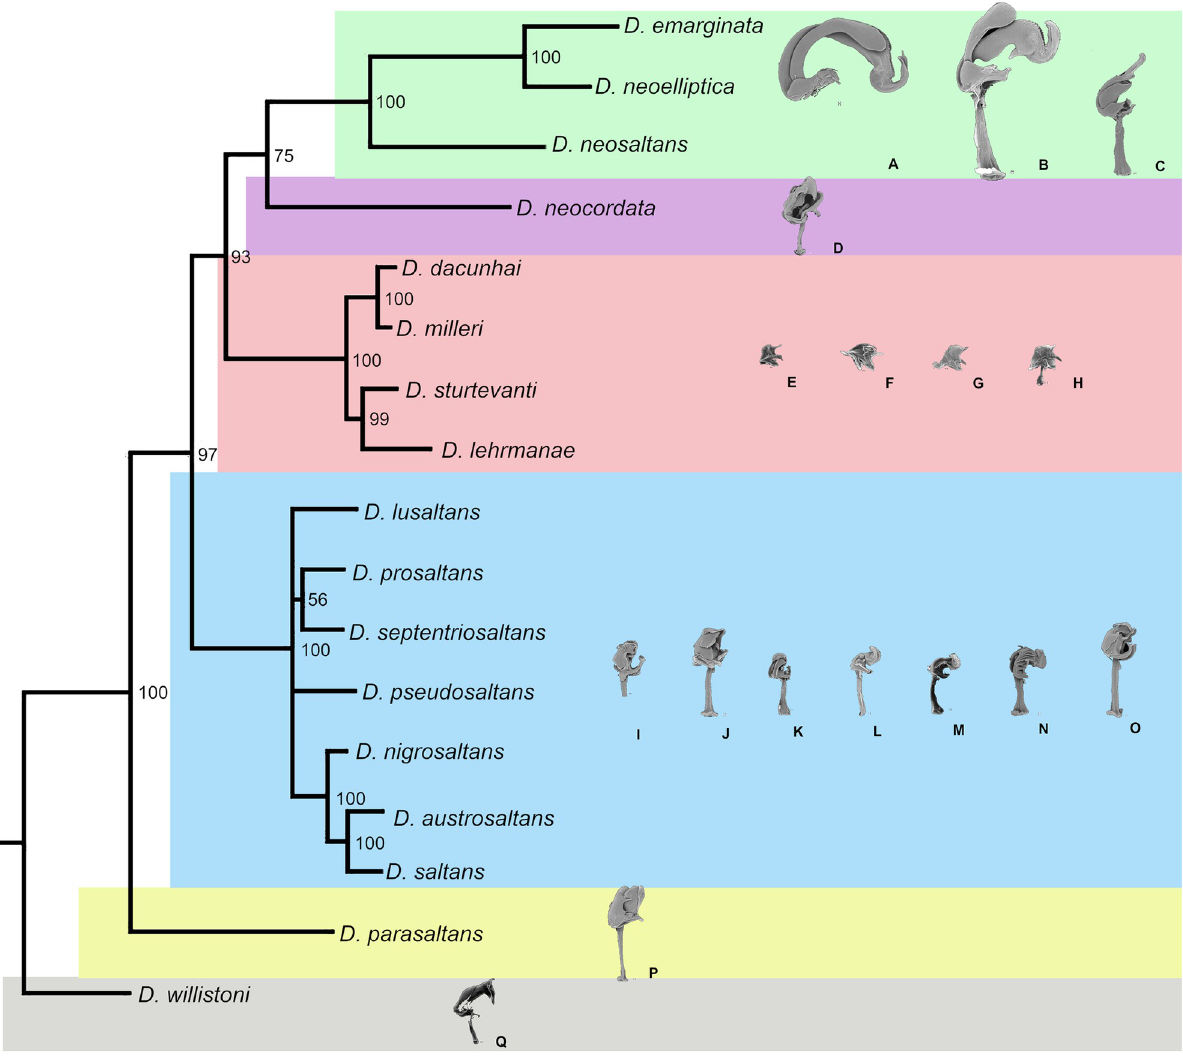
Fig 2. Phylogenetic relationships among species of the saltans group inferred by the total evidence analysis with morphological and molecular data. Bayesian posterior probability (PP) is shown as percentage on each node. The phallus of each species is shown in profile on the same scale. The letters represent the phallus of the following species: A = D . emarginata , B = D . neoelliptica , C = D . neosaltans , D = D . neocordata , E = D . dacunhai , F = D . milleri , G = D . sturtevanti , H = D . lehrmanae , I = D . lusaltans , J = D . prosaltans , K = D . septentriosaltans , L = D . pseudosaltans , M = D . nigrosaltans , N = D . austrosaltans , O = D . saltans , P = D . parasaltans , Q = D . willistoni .